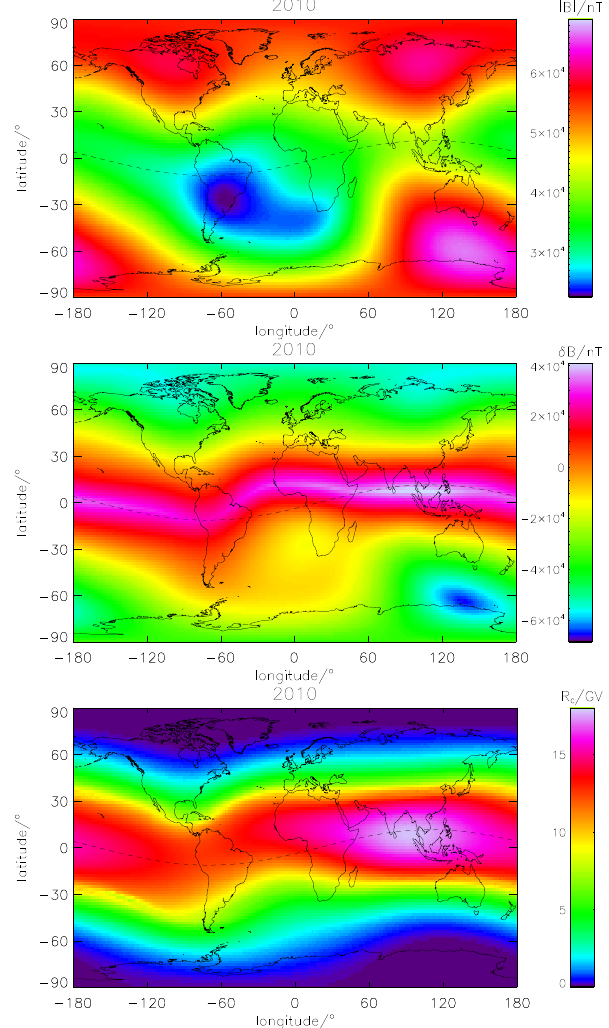
Fig. 1. The three parameters | B | (upper panel), δB (middle panel) and R C (lower panel) of the magnetic field configuration using the IGRF model for the year